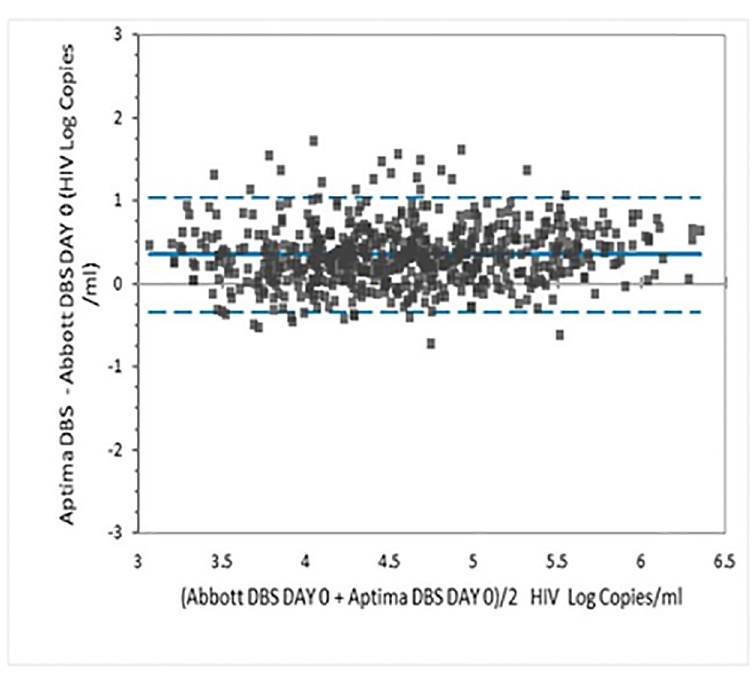
Fig 4. Bland Altman analysis of HIV VL results in fresh DBS tested in Aptima and Abbott RT